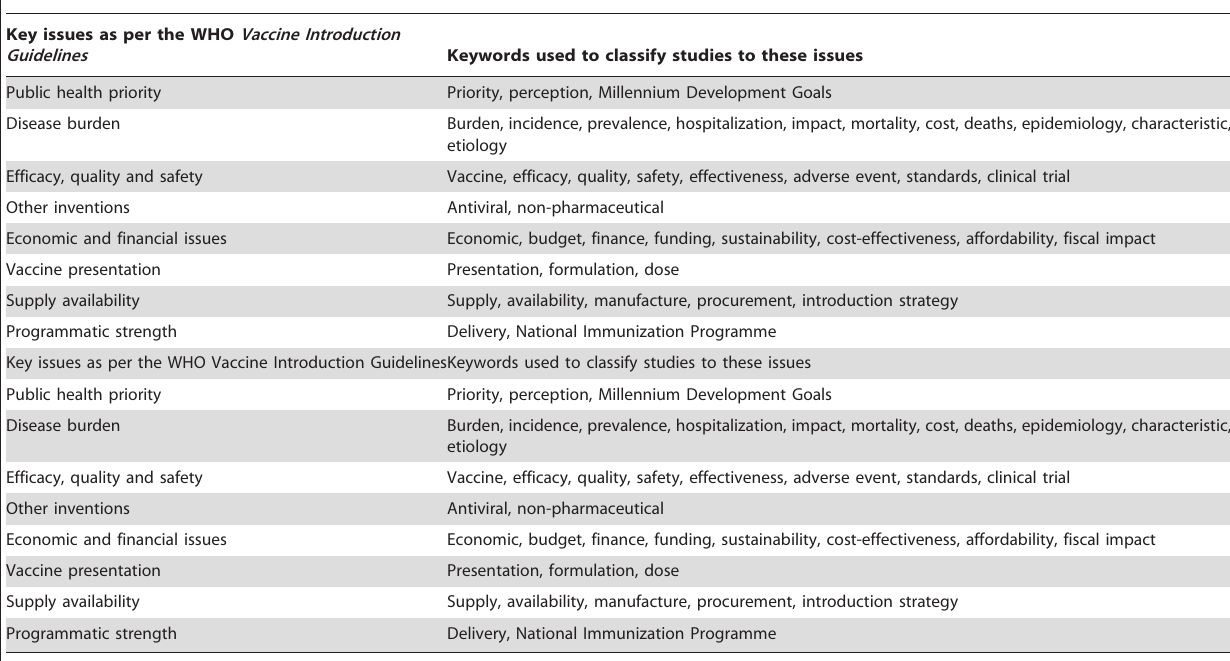
Table 1. Keywords used to include studies in the literature review and to allocate studies to the relevant issue according to the WHO Vaccination Introduction Guidelines